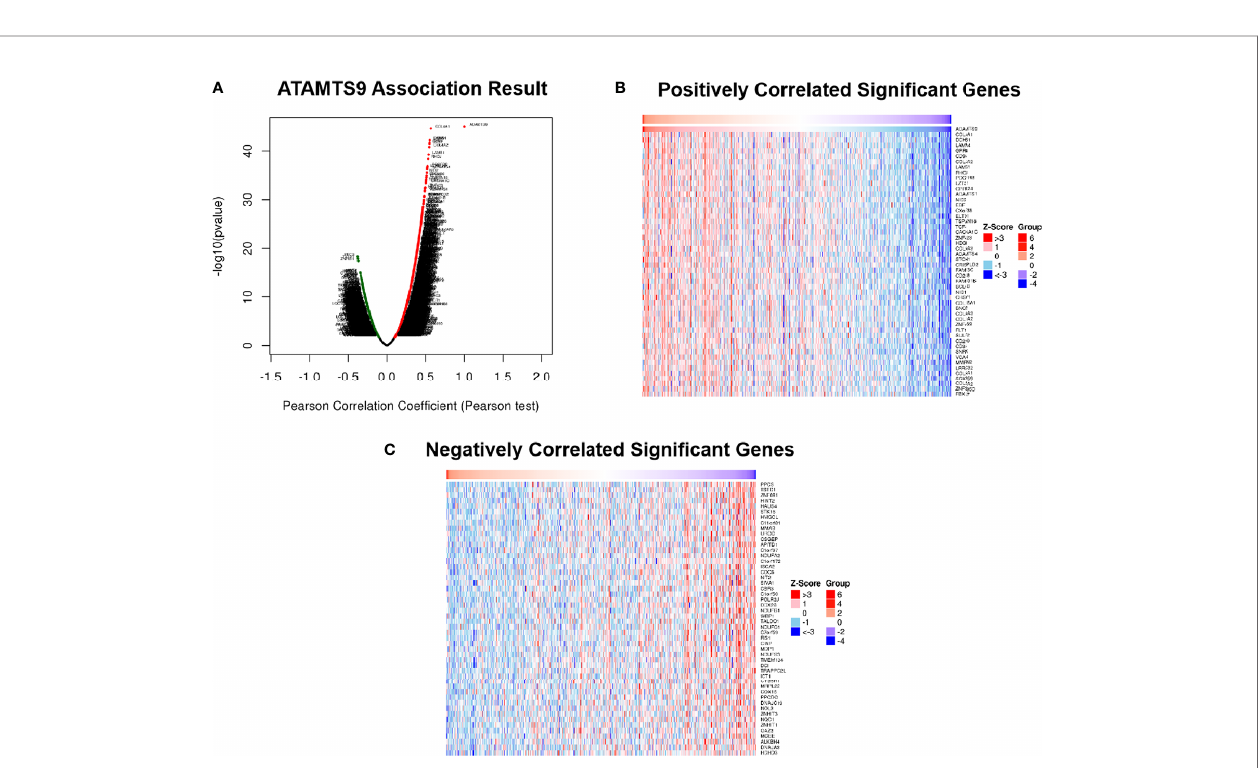
FIGURE 5 | DEGs in association with ADAMTS9 in LUAD according to LinkedOmics. (A) The correlation between ADAMTS9 and genes differentially expressed in LUAD was evaluated by a Pearson test. (B) Heat maps showed the top-50 signi fi cant genes positively and (C) negatively correlated with ADAMTS9 in LUAD. The red stands for positively correlated genes and the blue stands for negatively correlated genes. LUAD, lung adenocarcinoma.